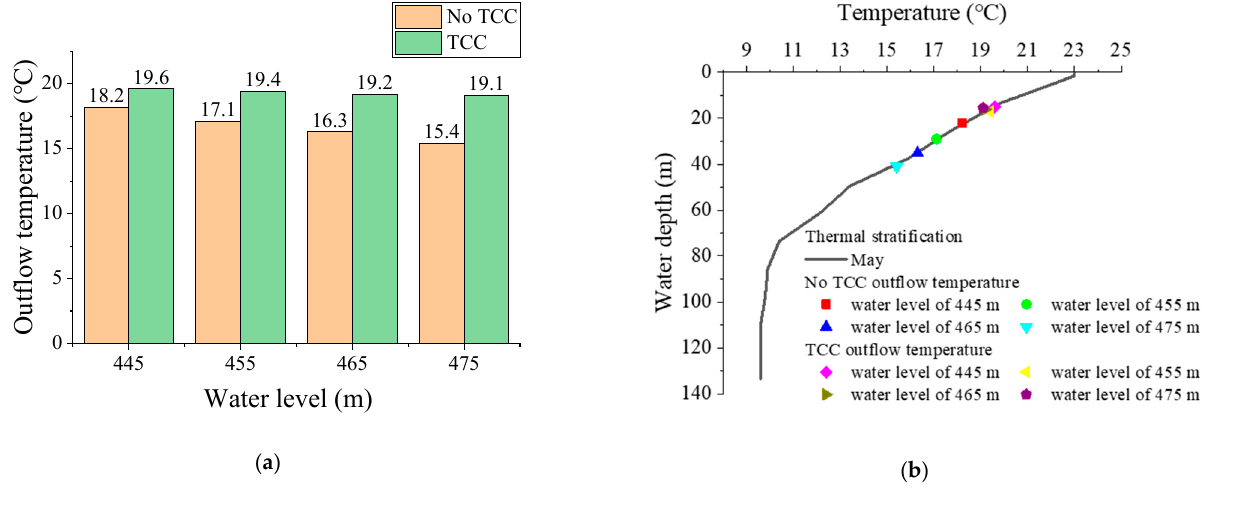
Figure 12. Comparison of outflow temperature: ( a ) before and after TCC implementation; ( b ) different water